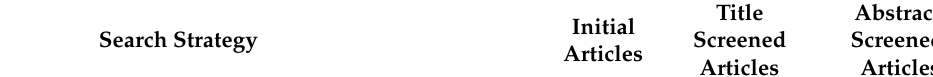
Table 1. Search strategies for the four